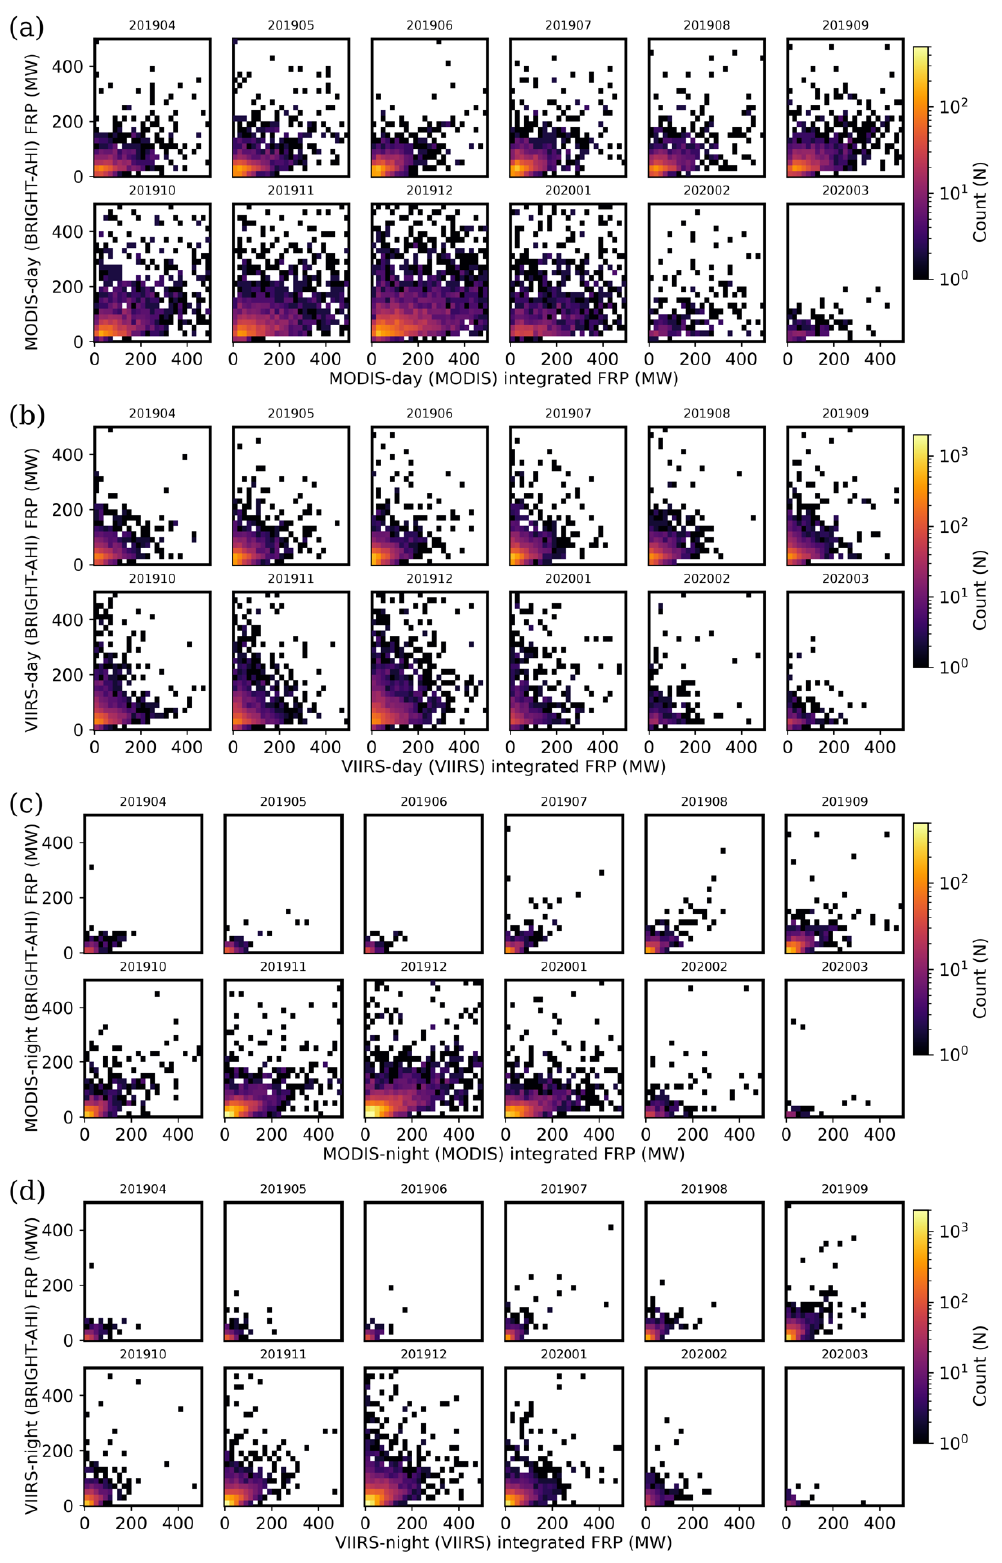
Figure 3. ( a ) Two-dimensional FRP histograms of month-by-month non-saturated MODIS-day (MODIS) FRP versus MODIS-day (BRIGHT/AHI) FRP values, individual plots for each month start April 2019 and end March 2020 (with the month shown above each plot as YYYYMM). ( b – d ) Same as ( a ) except for VIIRS-day, MODIS-night, and VIIRS-night, respectively.